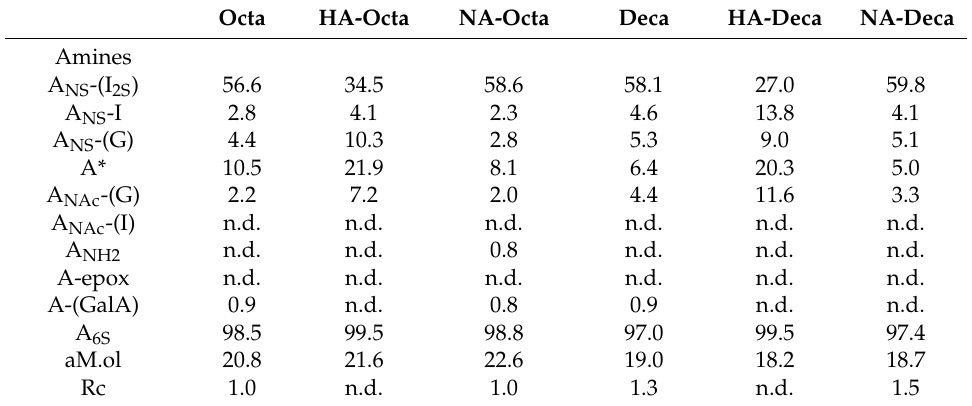
Table 2. Percent content of variously substituted glucosamine and uronic acid residues in octa and